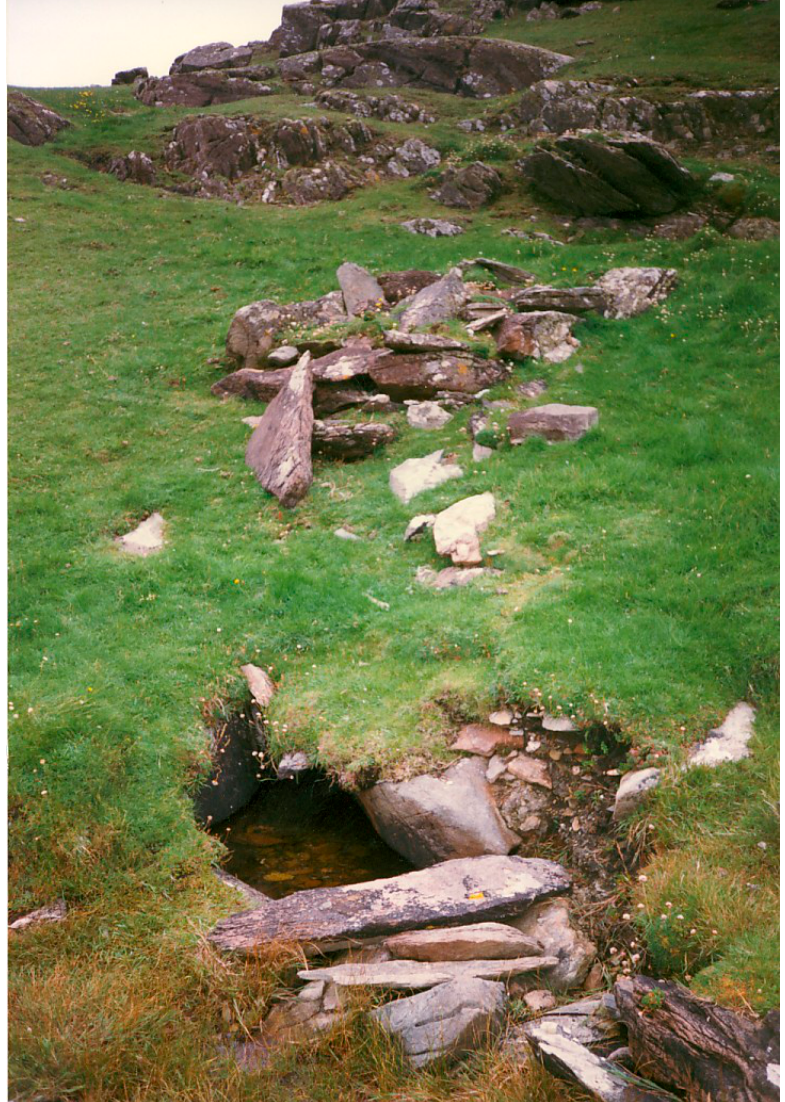
Figure 1. Tobar Mhúire (Mary’s Well), Caher Island, Co. Mayo. Figure 1. Tobar Mh ú ire (Mary’s Well), Caher Island, Co.